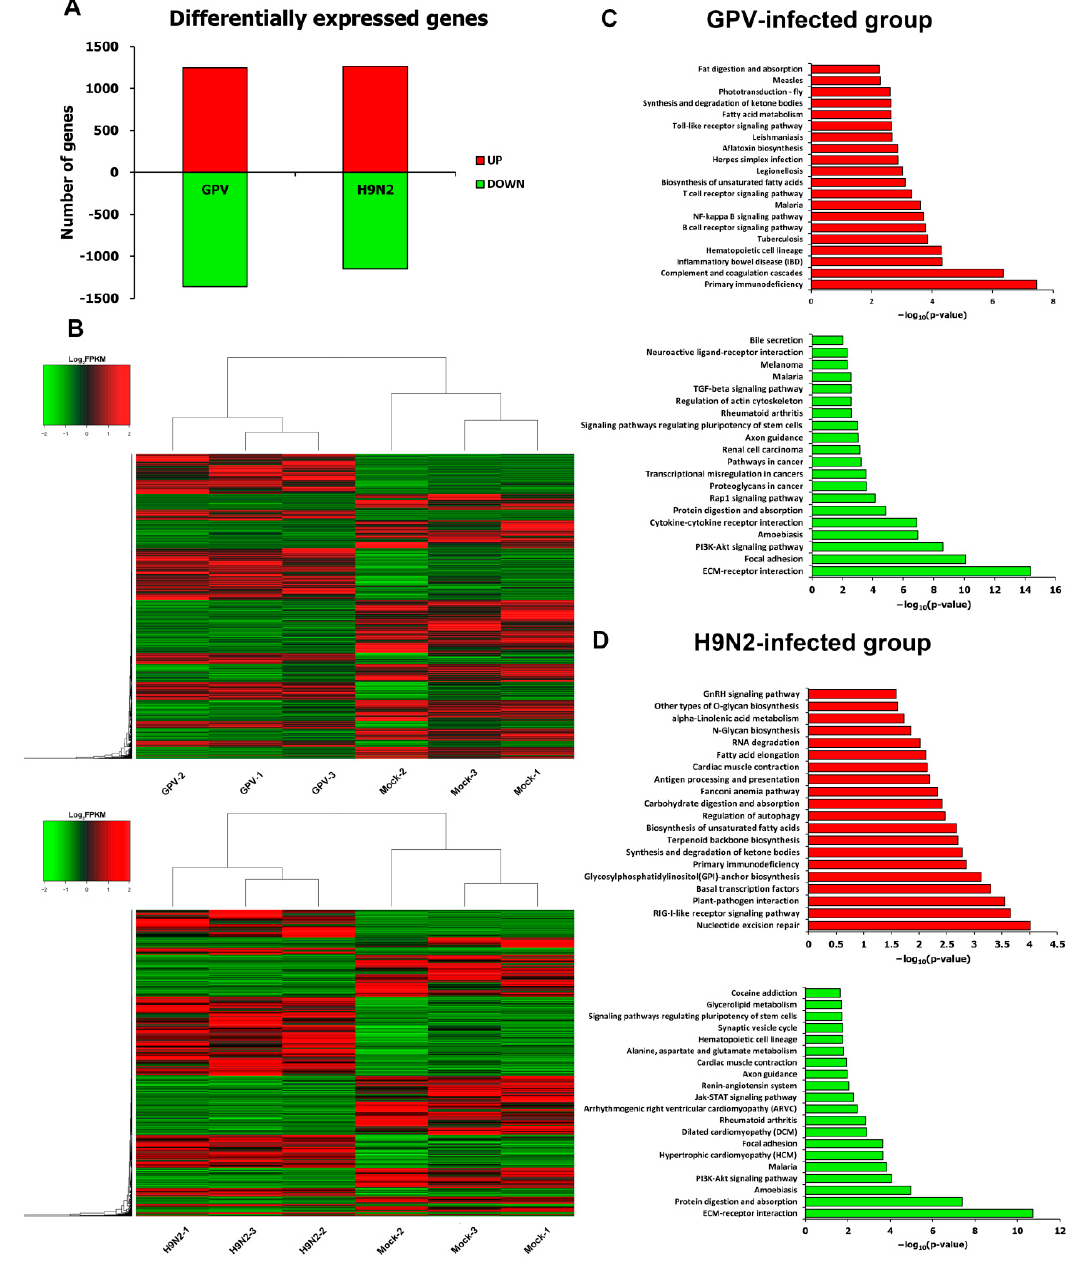
Figure 2. Analysis of the differentially expressed genes after infection with GPV and H9N2. ( A ) The number of differentially expressed genes after infection with GPV and H9N2; ( B ) hierarchical clustering analysis of differentially expressed genes in the GPV- and H9N2-infected groups; ( C ) KEGG enrichment analyses of the up- (red bar chart) and down-regulated genes (green bar chart) in the GPV-infected groups; and ( D ) KEGG enrichment analyses of the up-(red bar chart) and down-regulated genes (green bar chart) in the H9N2-infected groups. Only the top 20 pathways are listed here.